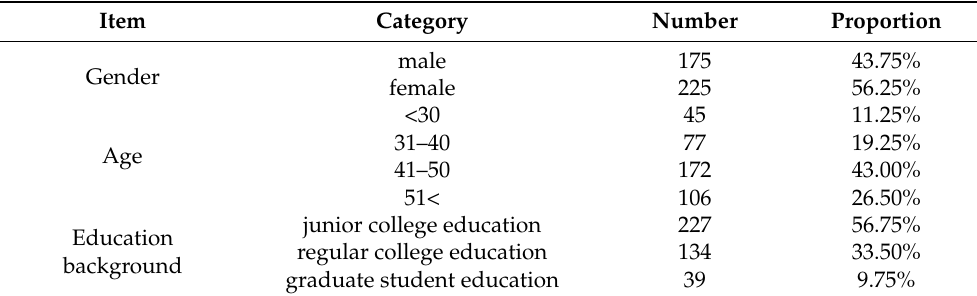
Table 4. Basic information of